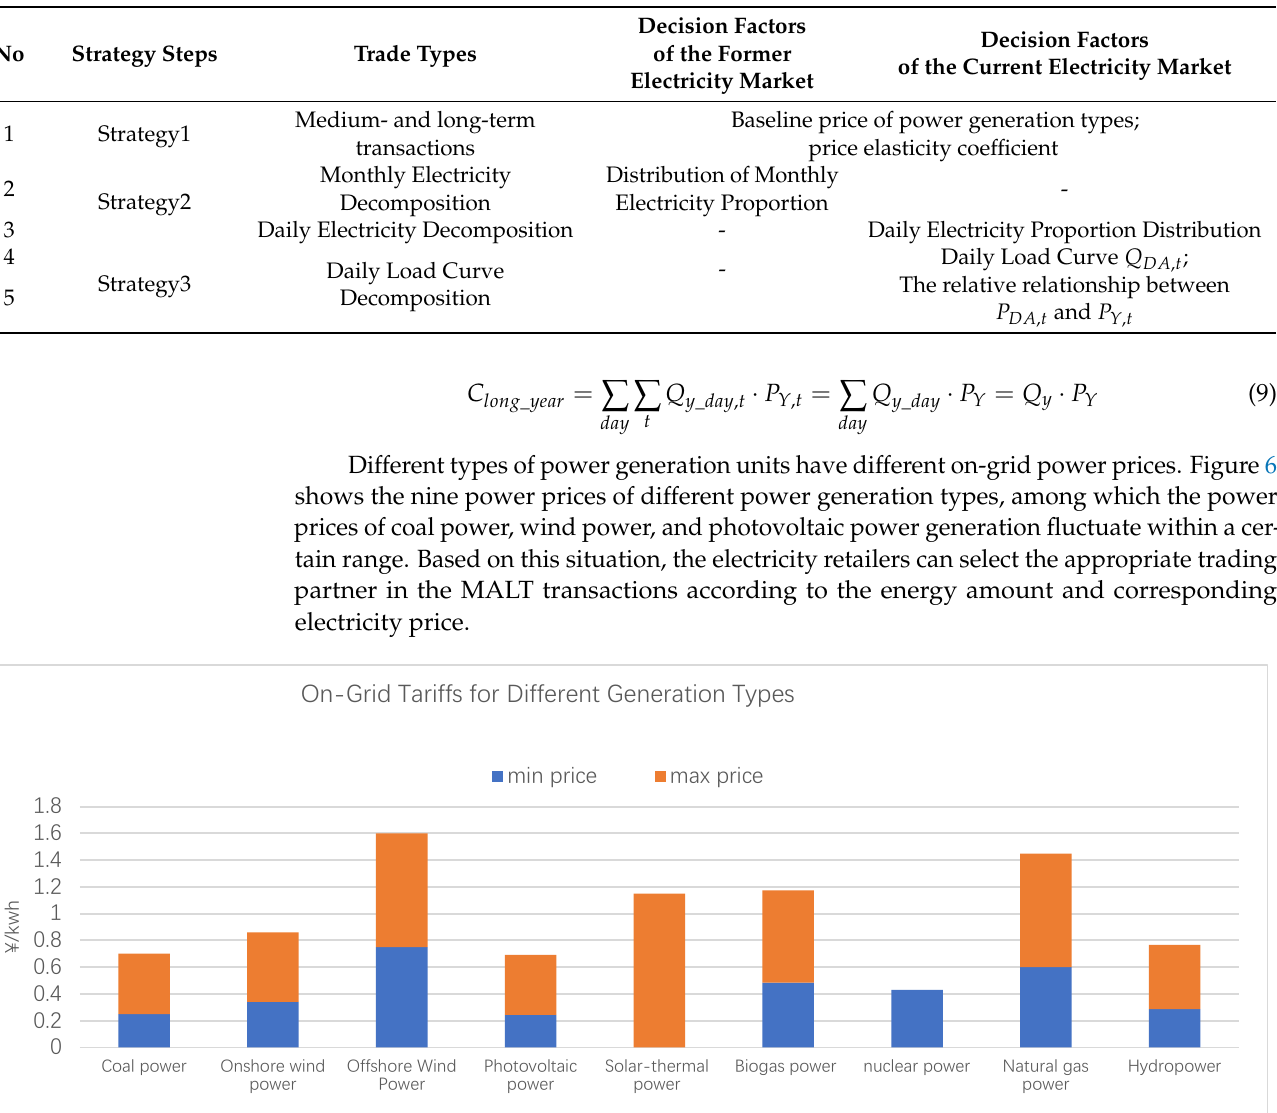
Table 2. Comparison of power market decision-making factors.